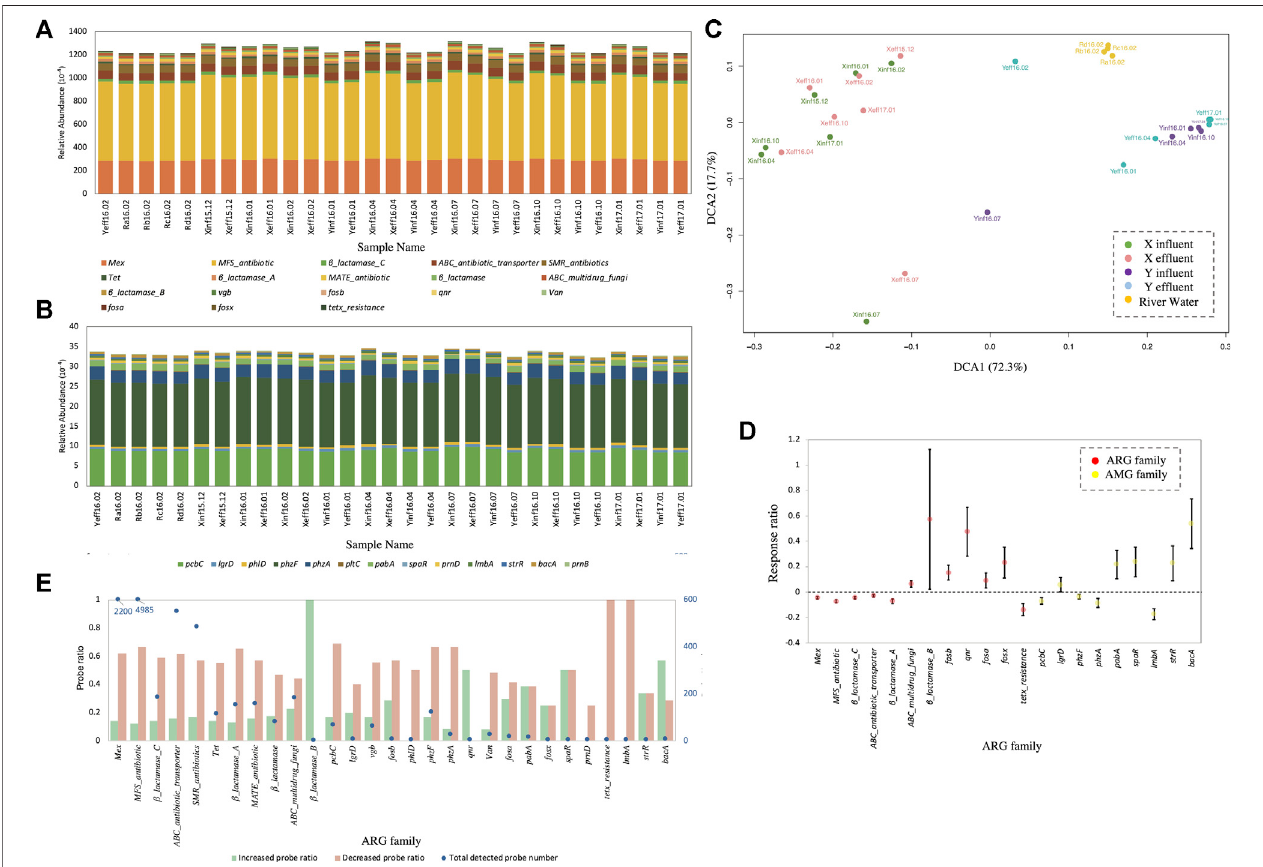
FIGURE4| ARGsand AMGs ofwastewatersamples. (A) Relativeabundance ofARGsat thegenefamily level. (B) Relative abundance ofAMGsat the genefamily level. (C) DCA at the Probe level. (D) Response ratio analysis on the gene family level of ARGs and AMGs in Y-WWTP compared with X-WWTP. (E) Probe quantities detected in each gene family and ratio of probes which increased or decreased in relative abundance detected in Y-WWTP compared with those detected in X-WWTP.